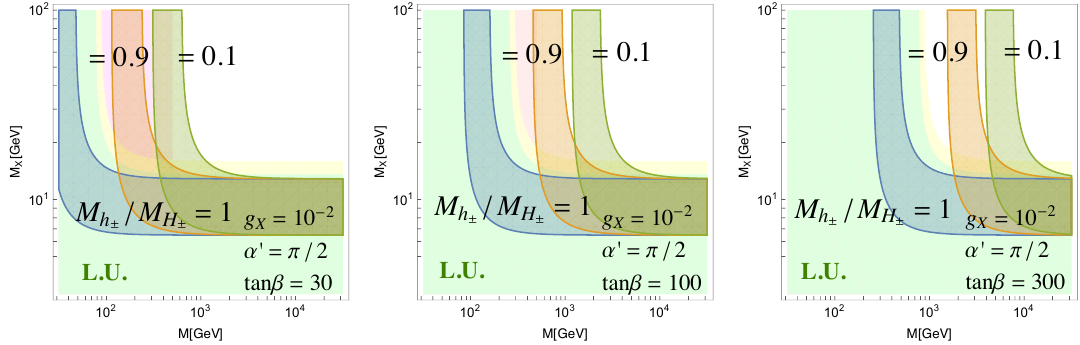
Figure 6 . Parameter space favored by (cid:1) a (cid:22) for M h =M H = 1 (blue), 0 : 9 (orange) and 0 : 1 (green) (cid:6) (cid:6) and disfavored by the universality in leptonic (cid:28) decays at 1 (cid:27) (light green) and 2 (cid:27) (light yellow) levels. The M (cid:6) > 500 GeV bound is drawn in light pink. These plots all assume g = 10 (cid:0) 2 ; (cid:11) 0 = (cid:25)= 2 X and M 2 (cid:17) M 2 = M 2 = M 2 = M 2 for de(cid:12)niteness. The left, middle, right plots are for H A h (cid:6) H (cid:6) tan (cid:12) = 30 ; 100 ; 300,